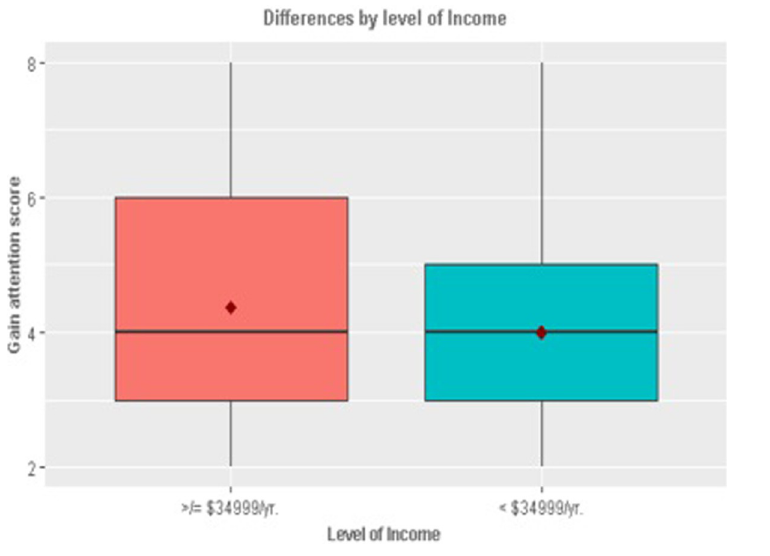
Fig 5. Significant differences by income.